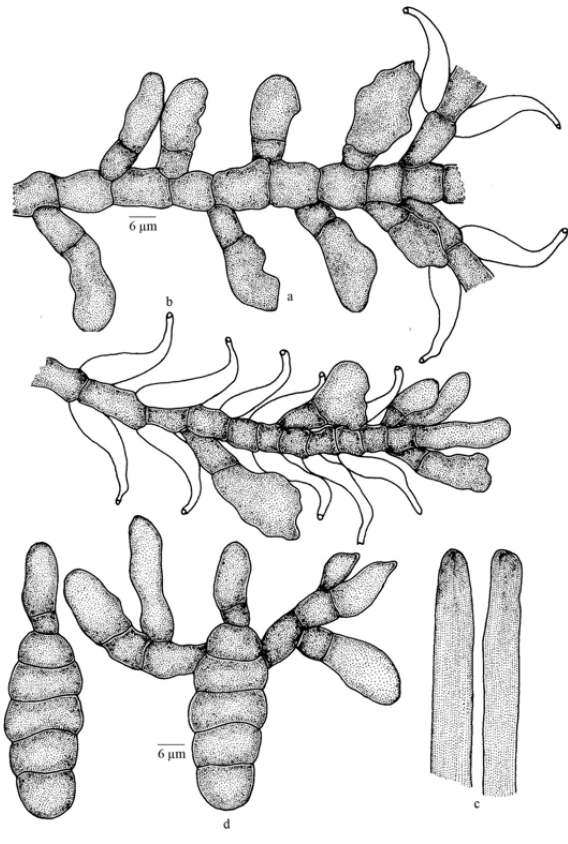
Figure 125. Meliola vatsavayae a - Appressorium; b - Phialide; c - Apical portion of mycelial setae; d - Ascospores